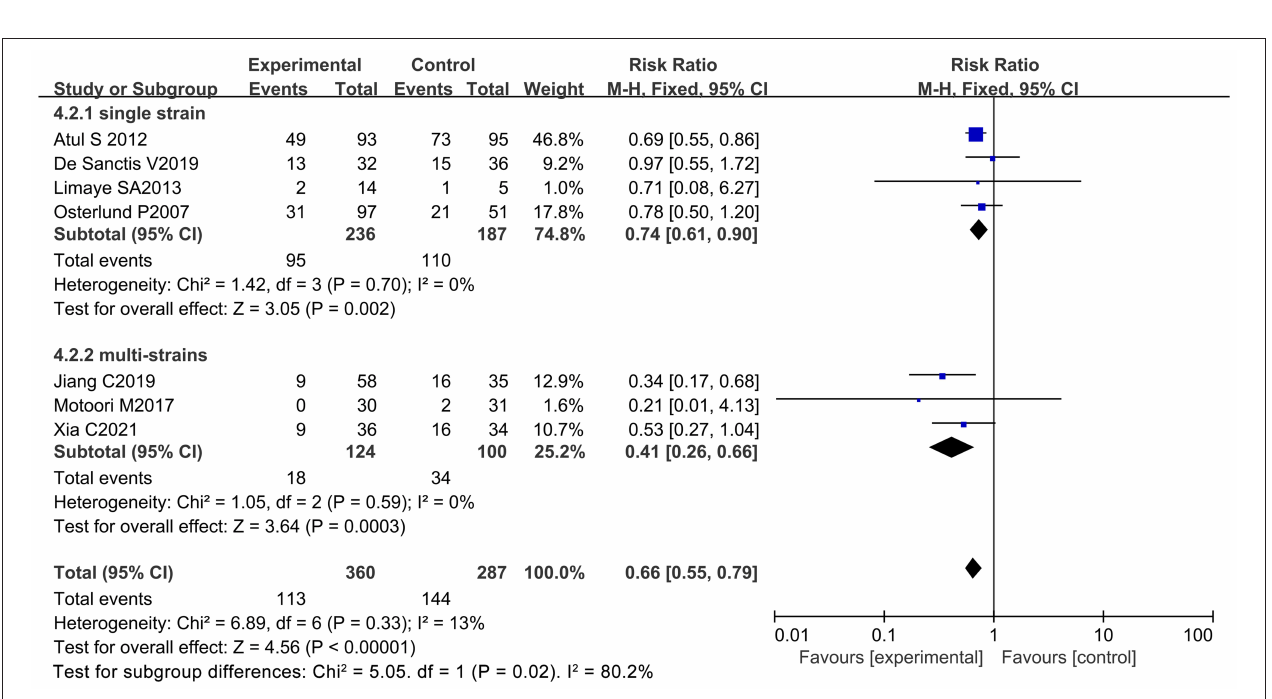
FIGURE 12 | Subgroup analysis of the inhibitory effect of bacterial number on the incidence of oral mucositis in cancer patients.